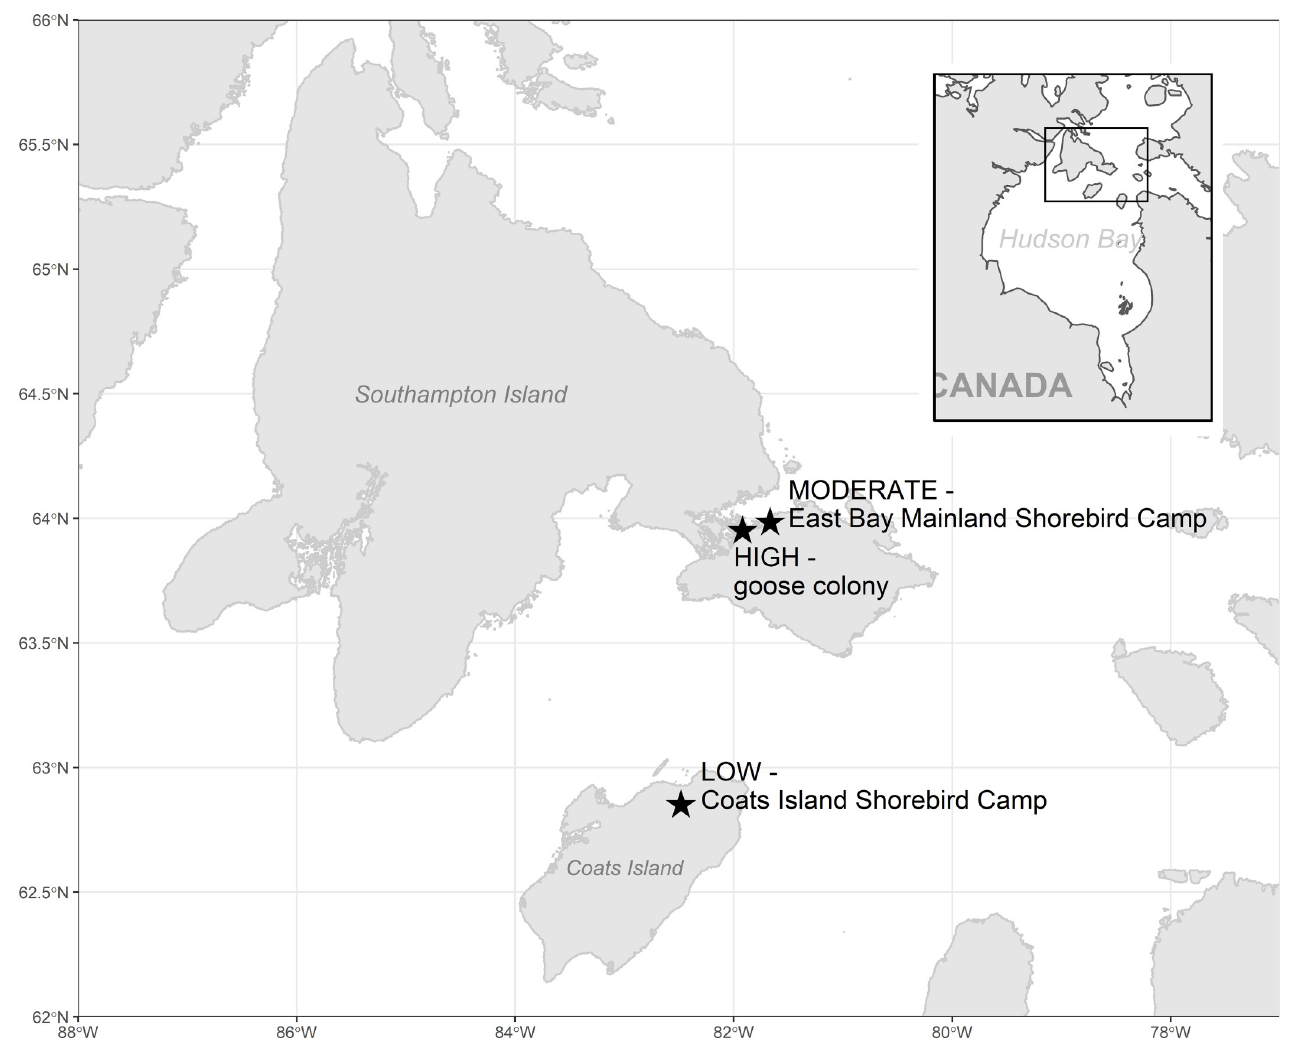
Fig 1. Locations of three study sites situated at increasing distances from a mixed lesser snow and Ross’ goose colony on Southampton Island and Coats Island, Nunavut.